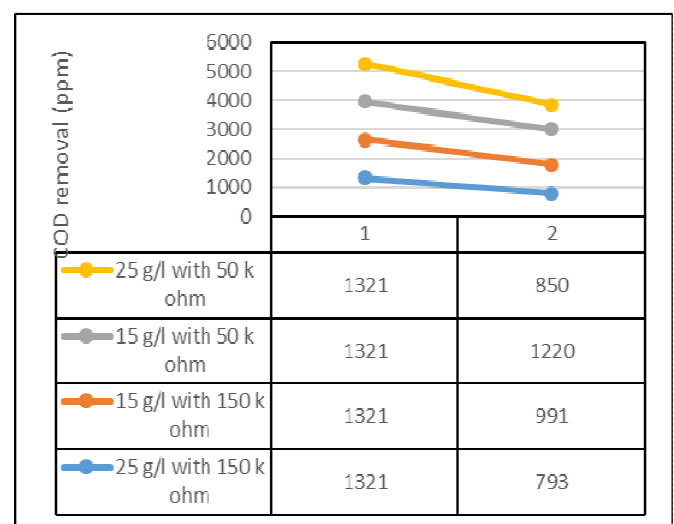
Fig. 6. Anode chamber COD elimination effectiveness in